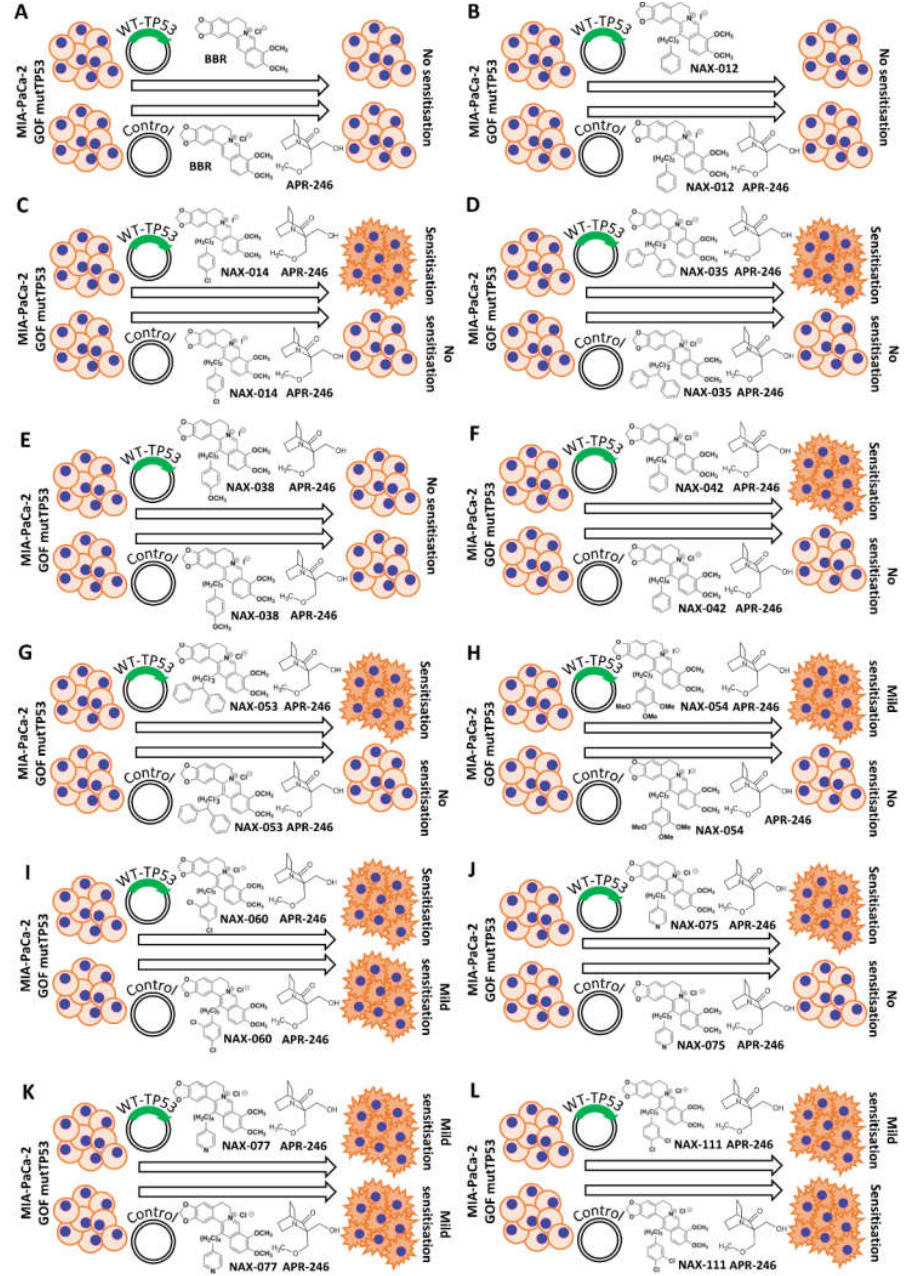
Figure 10. Chemical structures of BBR and NAX compounds and the potential effects of the mutant TP53 reactivator APR-246 to increase their toxicity of MIA-PaCa-2 + pLXSN and MIA-PaCa-2 + WT-TP53 cells. Abilities of APR-246 to interact with BBR and NAX compounds and to cause increased growth inhibition in MIA-PaCa-2 cells either in the presence of GOF m-TP53 or GOF-mTP53 + introduced WT-TP53. Mut-TP53, mutant TP53. ( A ) = Berberine, ( B ) = NAX012, ( C ) = NAX014, ( D ) = NAX035, ( E ) = NAX038, ( F ) = NAX042, ( G ) = NAX053, ( H ) = NAX054, ( I ) = NAX060, ( J ) = NAX075, ( K ) = NAX077, ( L ) = NAX111. 3.4. Interactions between Berberine (BBR), Chemically Modified BBRs (NAX Compounds) and Then, we tested the same panel of compounds as in the case of MIA-PaCa-2 cells APR-246 in PANC-28 + pLXSN and PANC-28 + WT-TP53 Cells on PANC-28 cells. The addition of APR-246 had no or only moderate effects on the sensitivity of PANC-28 + pLXSN to NAX compounds (Figures 11–16). The best results for PANC-28 + pLXSN cells were obtained in the combination with NAX012: APR-246 lowered the IC 50 for this compound four-fold (Figure